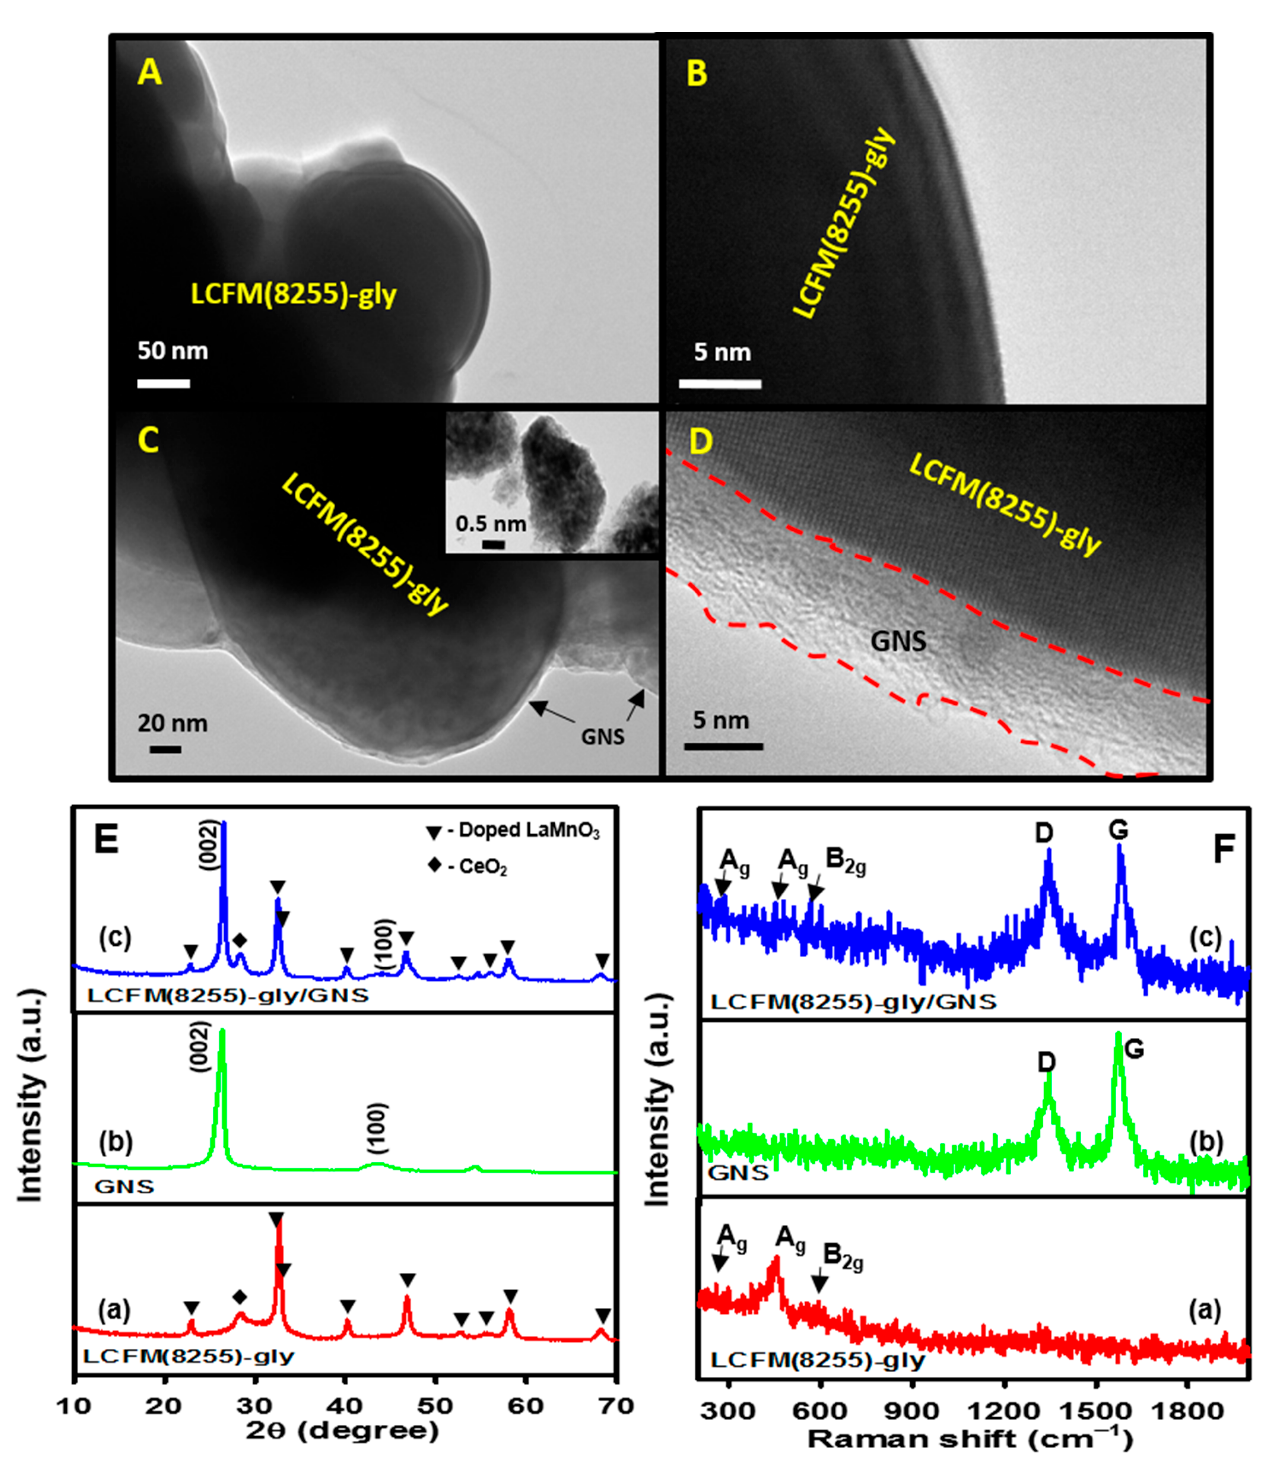
Figure 4. ( A , B ) TEM images of LCFM(8255)-gly and ( C , D ) LCFM(8255)-gly/GNS composite. ( E ) XRD patterns and ( F ) micro-Raman spectra of ( a ) LCFM(8255)-gly, ( b ) GNS and ( c ) LCFM(8255)-gly/GNS composite.